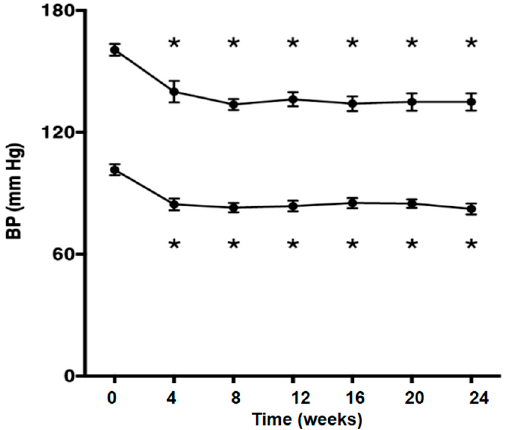
Figure 1. Systolic and diastolic blood pressure was decreased after the treatment with olmesartan. One-way repeated measures ANOVA followed by Tukey’s multiple comparisons test were used to compare values over the time course. p < 0.05 was considered as statistically significant (* p < 0.05).